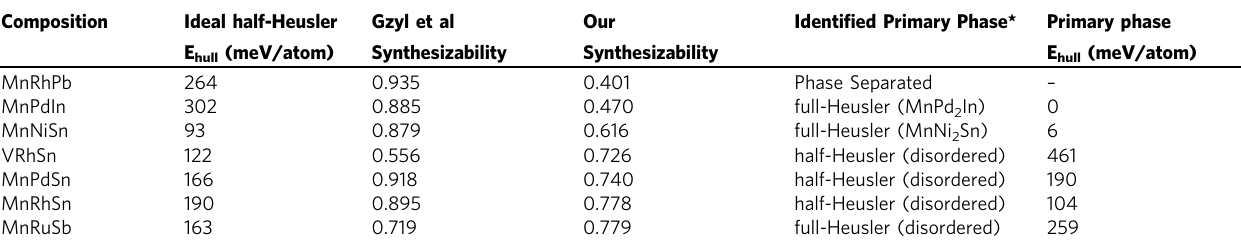
WesimulateXRDpatterns(seeSupplementaryFigs. 4and5)toidentifyeachcompound ’ sprimaryphase,andcalculatethe primaryphasestabilities usingDFT.Allcompositionsareunstableinthe half- Heusler structure, thus our model considers a composition synthesizable as a half-Heusler when its synthesizability >0.75. MnRhPb decomposition products are not reported, thus the stability is not calculated. *: multiple phases are observed for all compositions, but only the primary phase is shown here. Table summarizing our predictions compared to those made by Gzyl et al. 45 for the seven compositions their model predicted to be